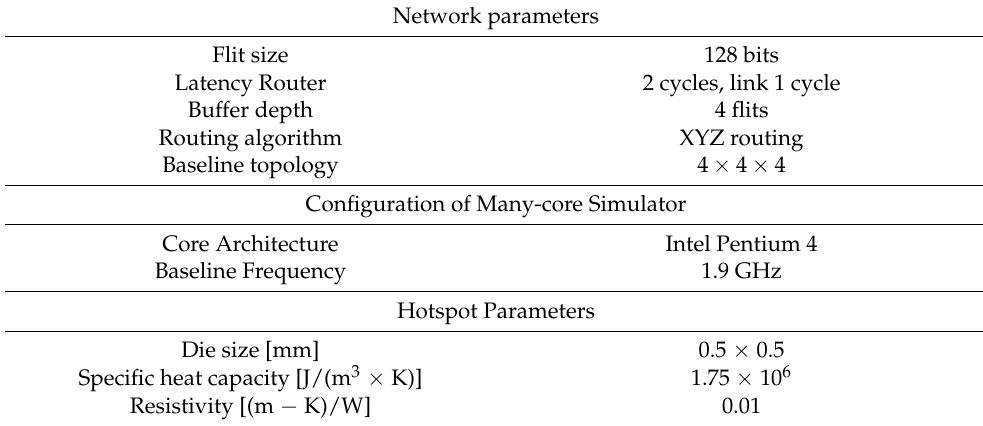
Table 1. The simulation